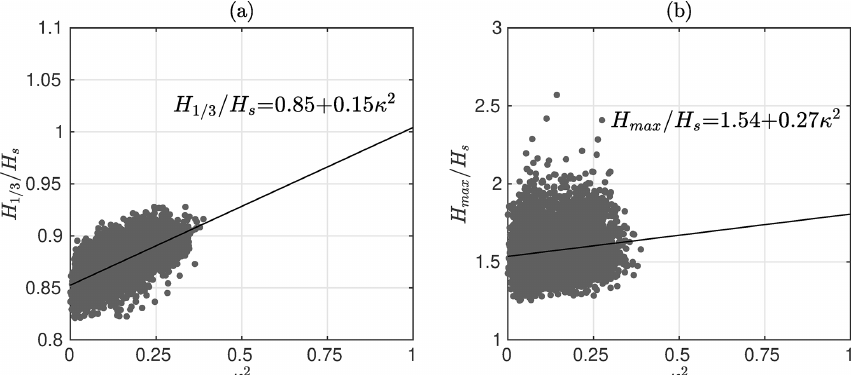
Figure 7. H 1 / 3 (a) and H max (b) at Suomenlinna (T2) relative to the significant wave height. The ratios are plotted against the spectral narrowness κ 2 . For an infinitely narrow spectrum ( κ 2 = 1), the linear regressions ( H 1 / 3 /H s = 1 . 00 and H max /H s = 1 . 81) are in good agreement with the theoretical predictions that Longuet-Higgins (1952) derived for a narrowband spectrum (Table